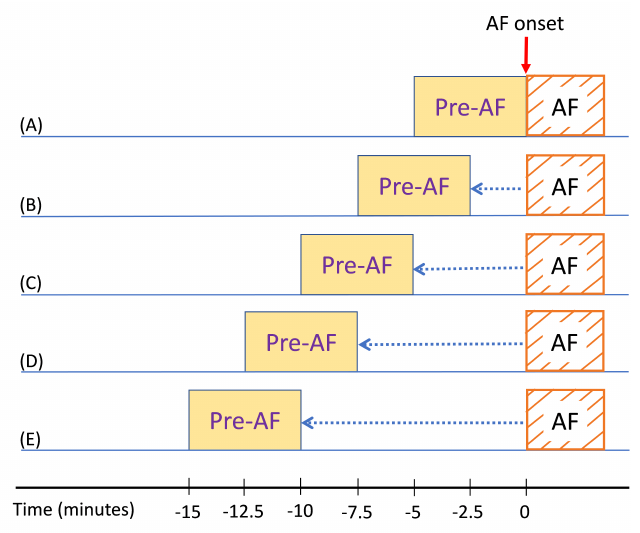
Figure 9. Illustration of AF prediction for moving backward in time from the onset.